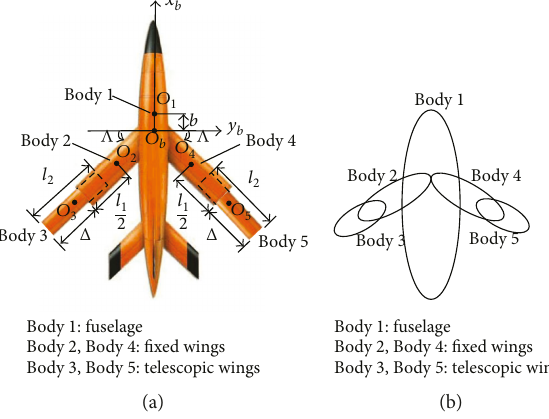
Body 1: fuselage Body 2, Body 4: fixed wings Body 3, Body 5: telescopic